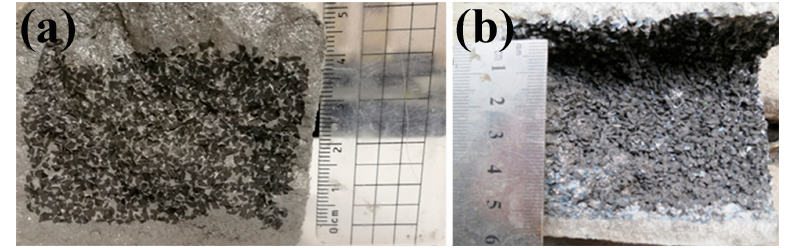
Figure 7. Different structural composite results: ( a ) Honeycomb; ( b ) Layer.